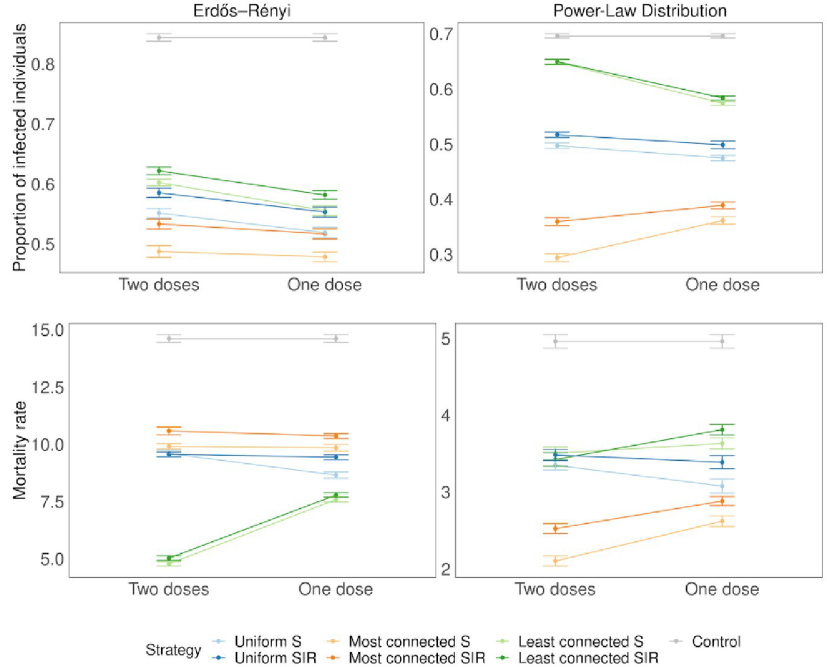
Fig 6. Dose sparing. Two doses: 25% of the population receives two doses of the vaccine (effectiveness 90%). One dose: 50% of the population receives a single dose of the vaccine (effectiveness 50%). Error bars represent standard deviation. The time of the vaccination tV is when the cumulative number of infected individuals reaches